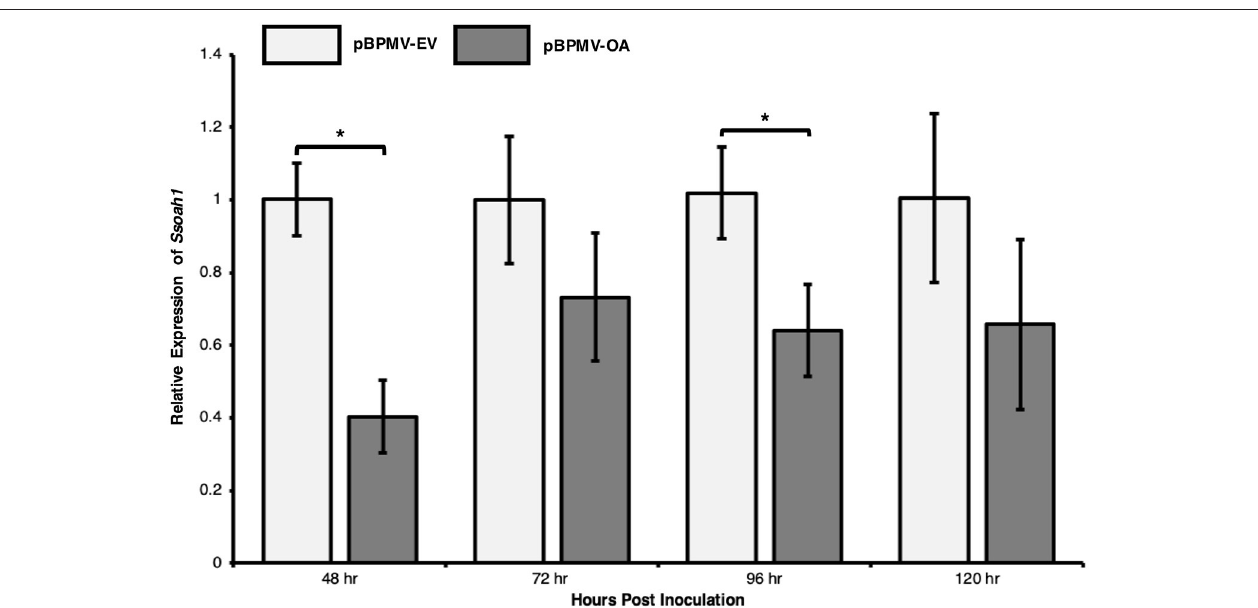
FIGURE 4 | Transcript levels of the target gene, Ssoah1 , were decreased in expression assays. Plants containing virus-induced gene silencing constructs, pBPMV-OA and empty vectors, pBPMV-EV were challenge with S. sclerotiorum strain 1980, using a cut petiole technique. RNA was extracted from stem tissue from three biological replicates and three experimental repetitions. Relative expression of Ssoah1 was normalized to S. sclerotiorum H3 and relative to the pBPMV-EV. Expression in pBPMV-OA treated plants tended to decrease for all time points, however, the difference was significant at 48h (* p < 0.01) and 96h ( p =